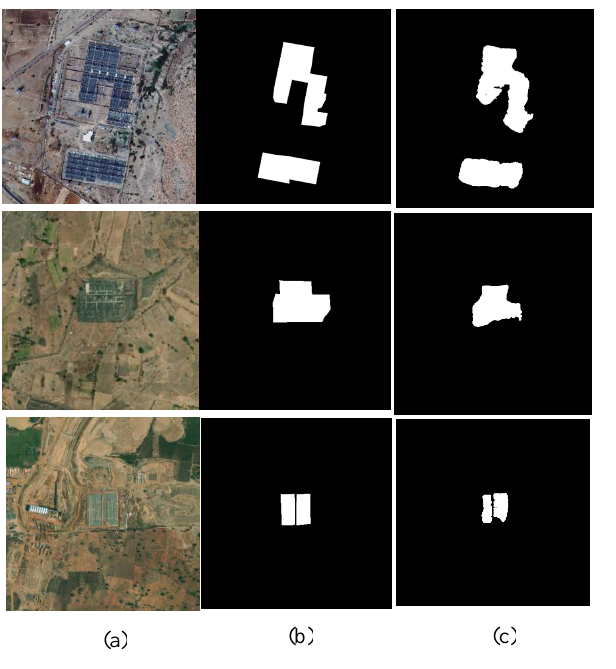
Figure 4 . illustrate the results, a) RGB image, b) Ground truth, c) Predicted